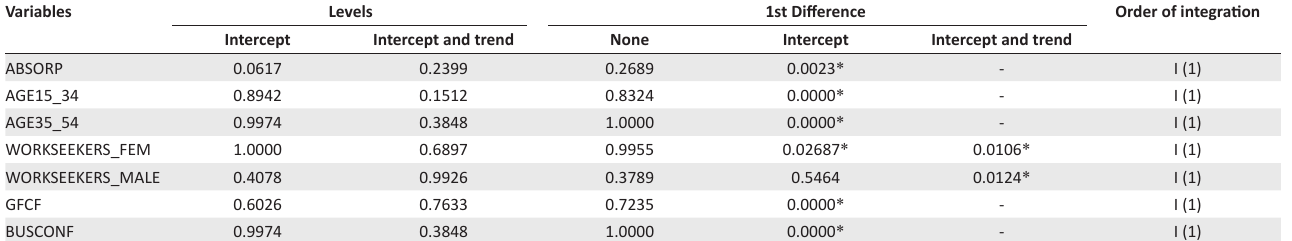
TABLE 3: Augmented Dickey–Fuller unit root tests results.